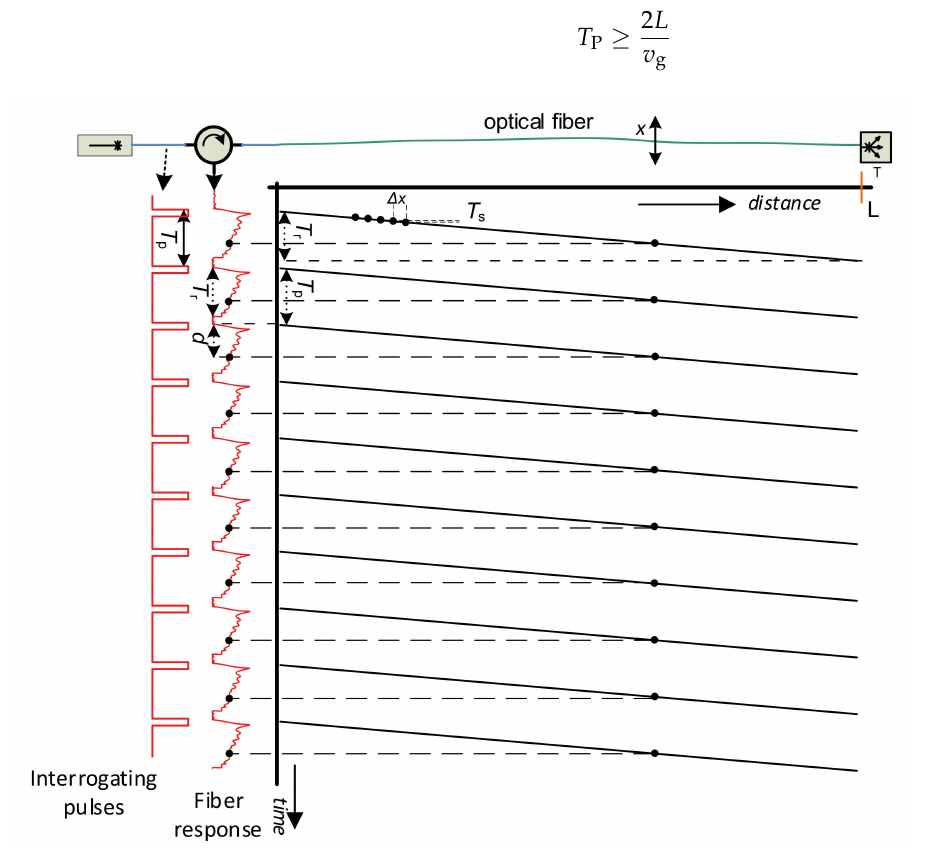
Figure 4. Time–spatial presentation of the fiber sensing and the fiber backscattering response on the sequence of optical interrogation